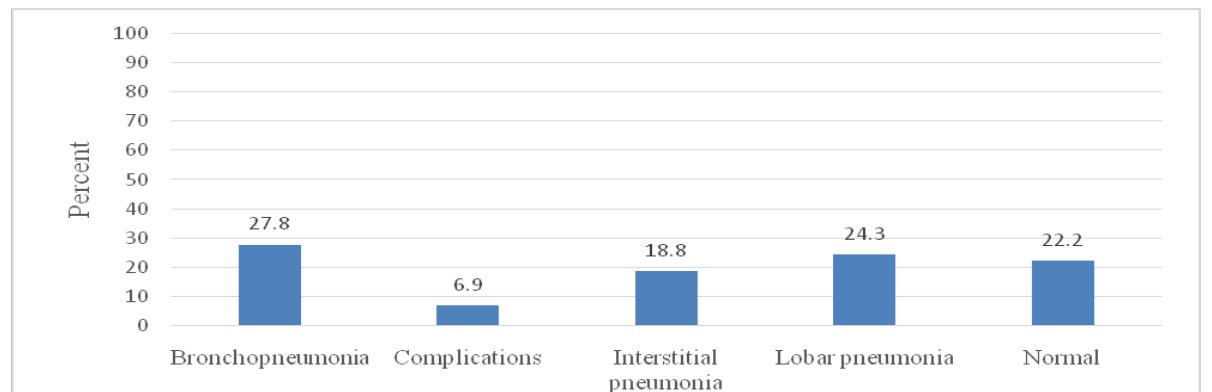
Figure 2: Radiological features of severe pneumonia